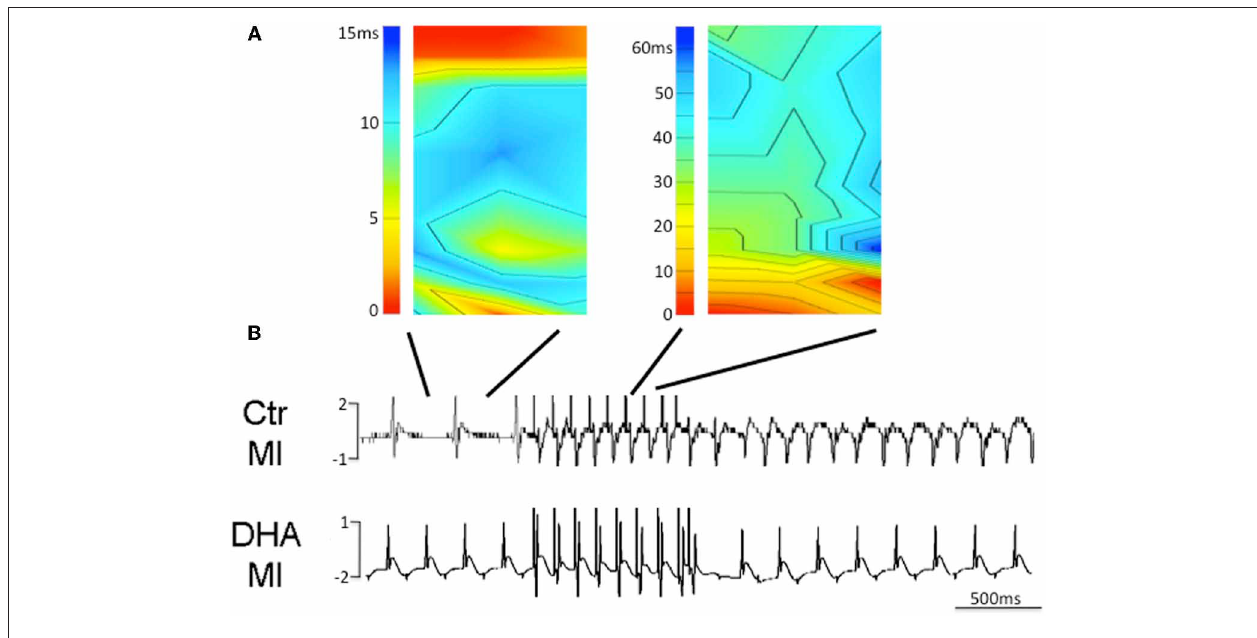
FIGURE 6 | Isochronal maps of sinus rhythm (SR) and induced ventricular tachycardia (VT) with a single premature stimulus (120ms drive cycle, S2 60ms) in a mouse fed a normal diet after MI